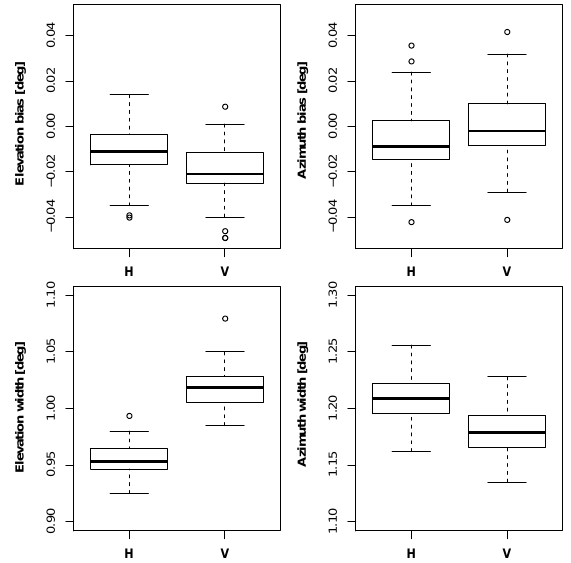
Figure 7. Elevation and azimuth pointing and image width results for H and V polarizations for 1month of data of the ANJ radar. In each panel, the median is shown with a thick line at 1st and 3rd quar- tiles by a box. Whiskers indicate data points closer than 1.5 times the box length from the quartiles, and data points beyond that are marked with